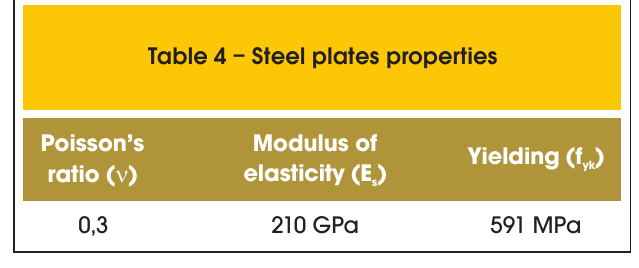
Figure 5 – Details of the finite element mesh, the supports and the applied load